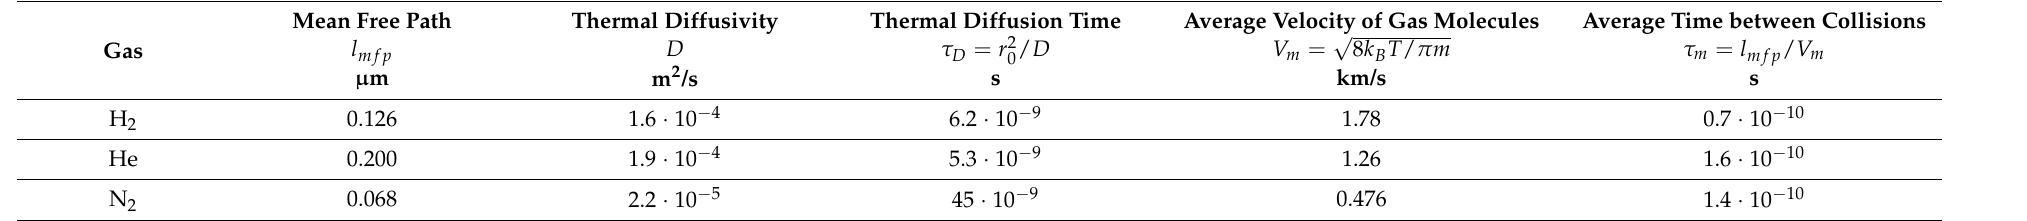
Table 3. Thermal parameters of gases at 300 K and 10 5